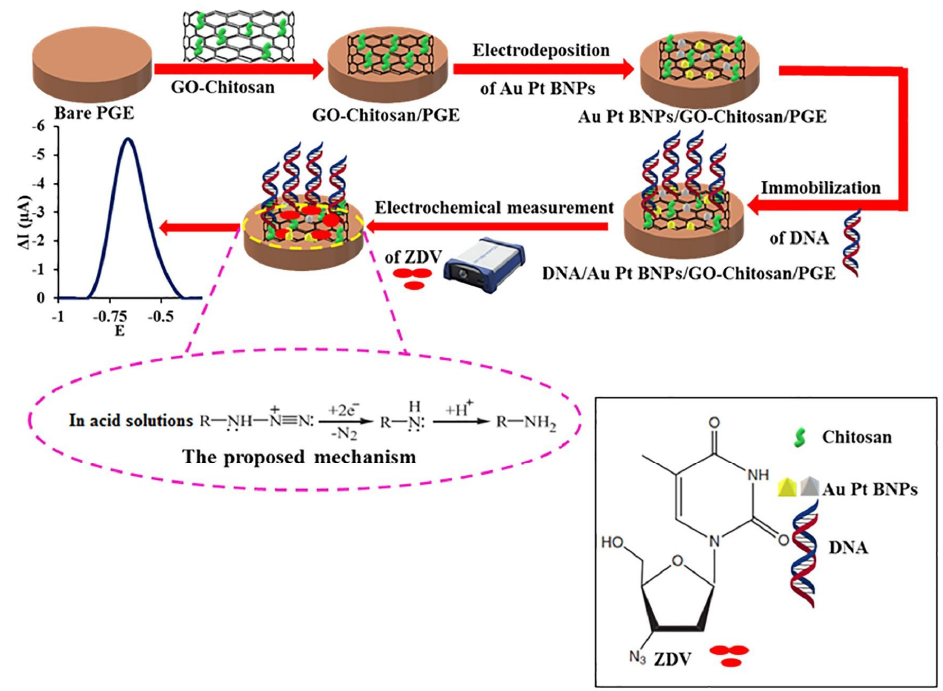
Figure 7. Schematic route for the fabrication of DNA/Au − Pt BNPs/GO − chit/PGE transducer surface for the development of an electrochemical biosensor for the detection of ZDV. Reprinted with permission from Ref. [40] . Copyright 2021, Elsevier.